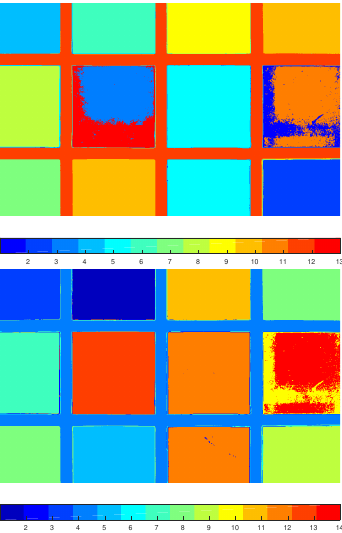
Figure 6. Kmeans clustering result when K is 13 and 14 . Border areas of color targets are hard. Three colors are clustered as same.